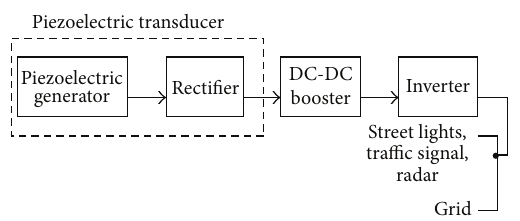
Figure 2: Process flow